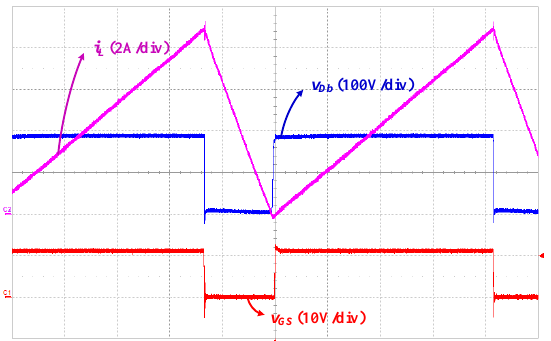
Figure 17. The turn-off ZCS waveform of the power diode D b under full load conditions (20 ms/div).